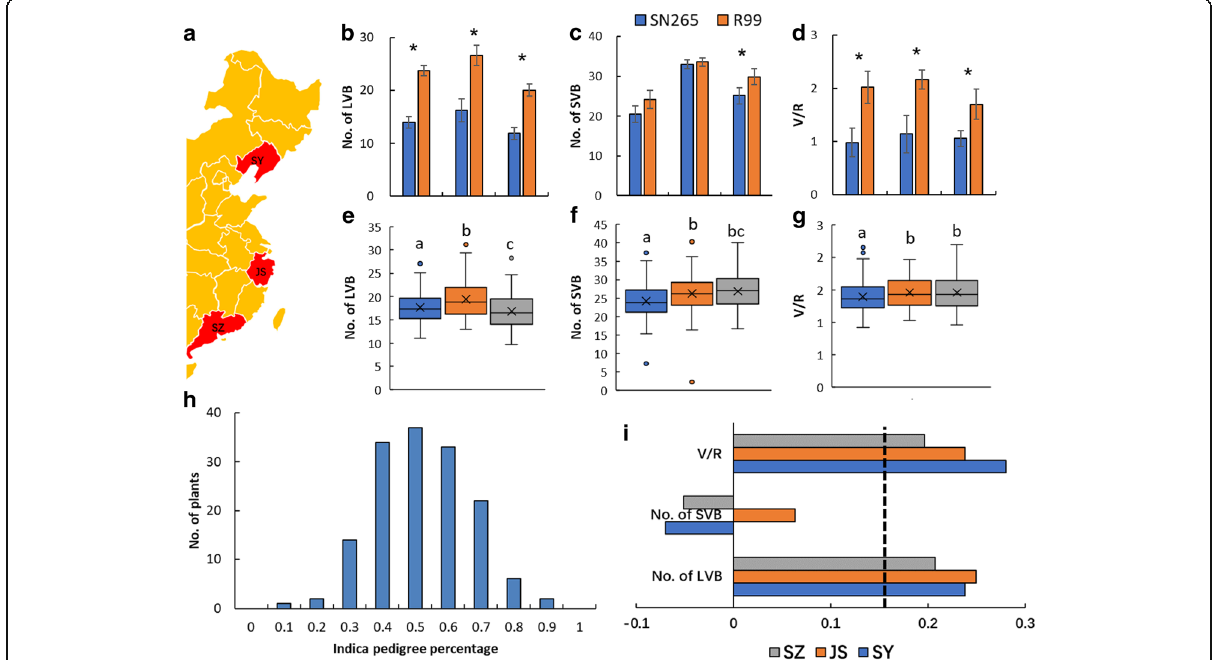
Fig. 1 The vascular bundle characteristics of the parent lines and RILs in the three areas. a The locations of the three cultivated areas. b – d The vascular bundle characteristics of SN265 and R99 in the three areas. e – g The vascular bundle characteristics of the RILs in the three areas. * represents significance at the 5% level. h The distribution of the indica pedigree percentage of RILs. i The correlation efficiency of indica pedigree percentage to vascular bundles. The dotted lines indicate significance at the 5%